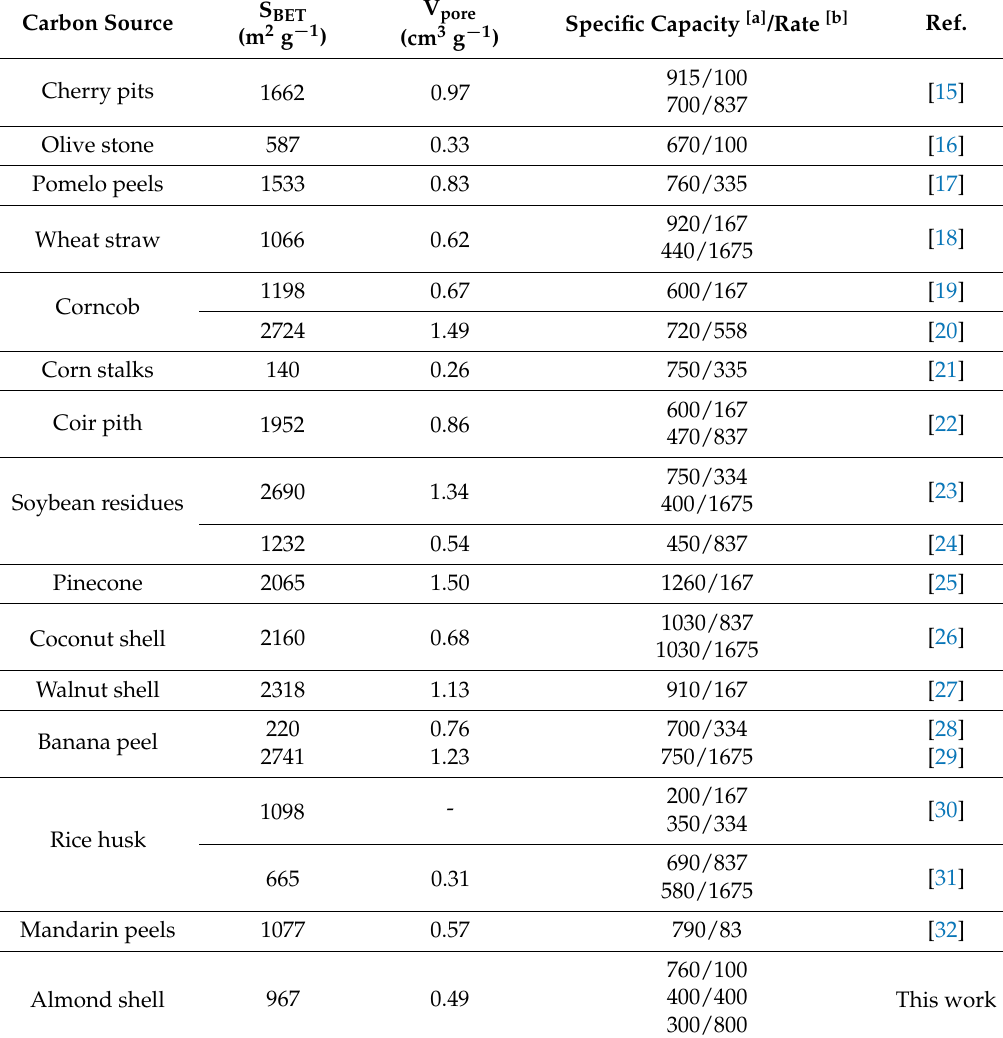
Table 1. The use of active carbon from non-edible biomass residues as cathodes in Li–S batteries. Carbon